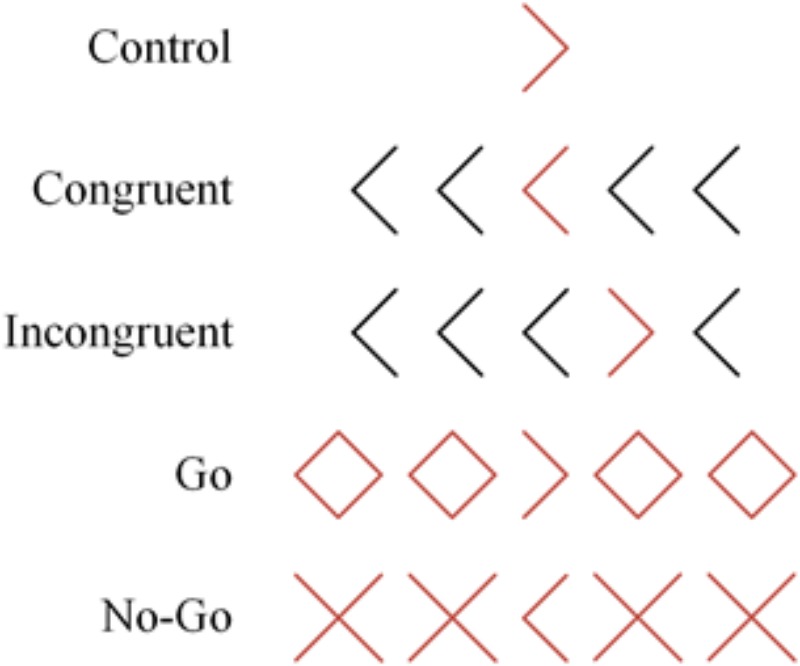
Examples of the different trial types of the advanced flanker task, adapted from Emmorey et al. (2008).